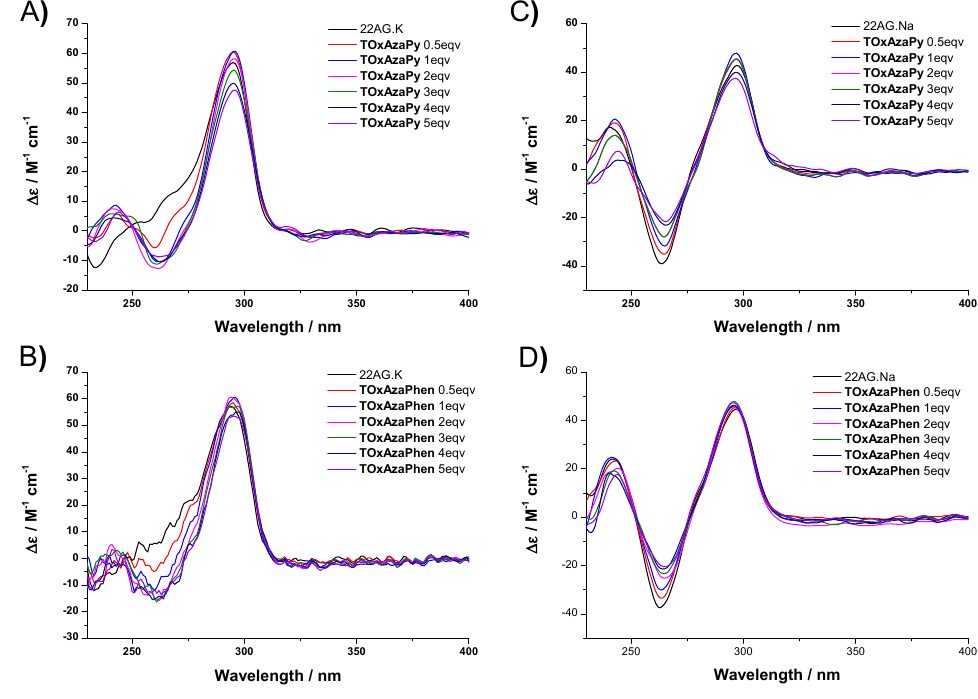
Figure 6. CD spectra of 22AG 5 µM alone and upon addition of increasing concentration of: ( A ) TOxAzaPy in 10 mM lithium cacodylate buffer (pH 7.2), 100 mM KCl; ( B ) TOxAzaPhen in 10 mM lithium cacodylate buffer (pH 7.2), 100 mM KCl; ( C ) TOxAzaPy in 10 mM lithium cacodylate buffer (pH 7.2), 100 mM NaCl; and ( D ) TOxAzaPhen in 10 mM lithium cacodylate buffer (pH 7.2), 100 mM NaCl.